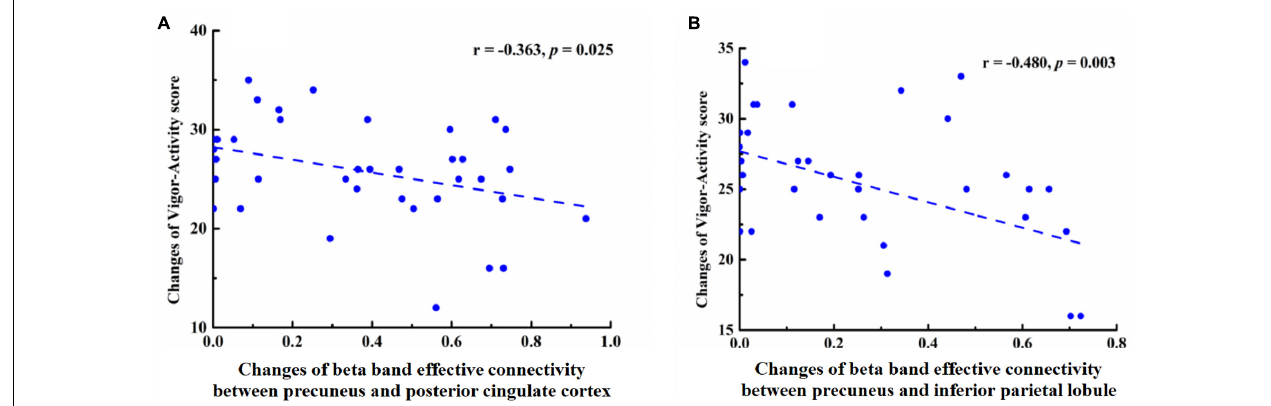
FIGURE 3 | Pearson correlation coefficient between changes in effective connectivity and changes in Vigor scores, (A) A negative correlation was found between beta-PC effective connectivity and Vigor score in the eyes open state (r = − 0.363, p = − 0.025). (B) A negative correlation was found between beta-PI effective connectivity and Vigor score in the eyes open state (r = − 0.480, p = −